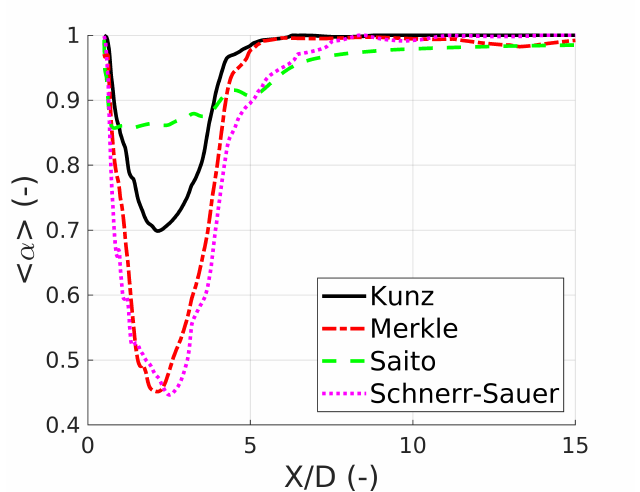
Figure 10. Mean liquid fraction downstream the cylinder along the centerline, results obtained considering standard coefficients.